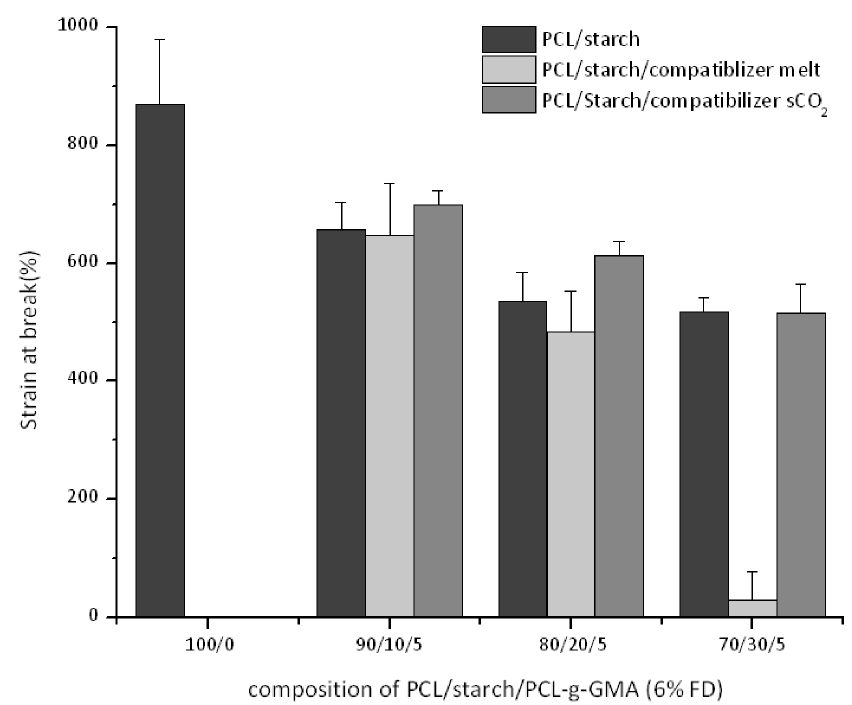
Figure 11. Strain at break for ternary PCL/Starch/PCL- g -GMA blends.